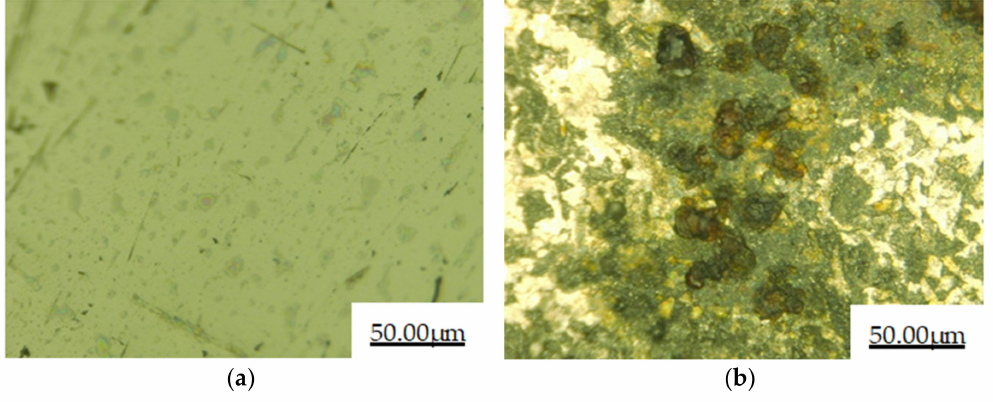
Figure 9. Salt spray corrosion morphology of the ( a ) cladding layer and ( b ) 27SiMn